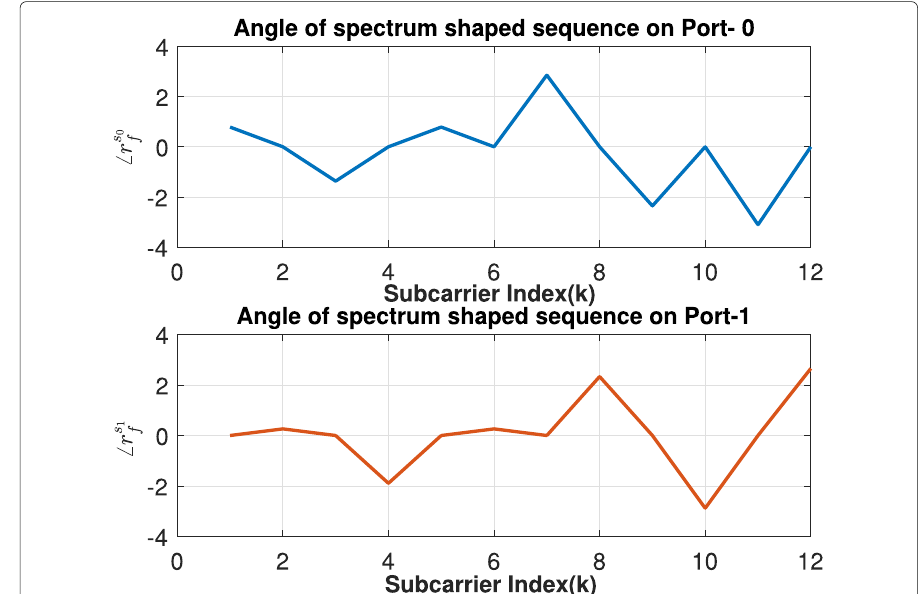
Fig. 9 Angle of r s 0 , r s 1 , i.e., the spectrum shaping filter outputs on port 0 and port 1 in the absence of f f precoder